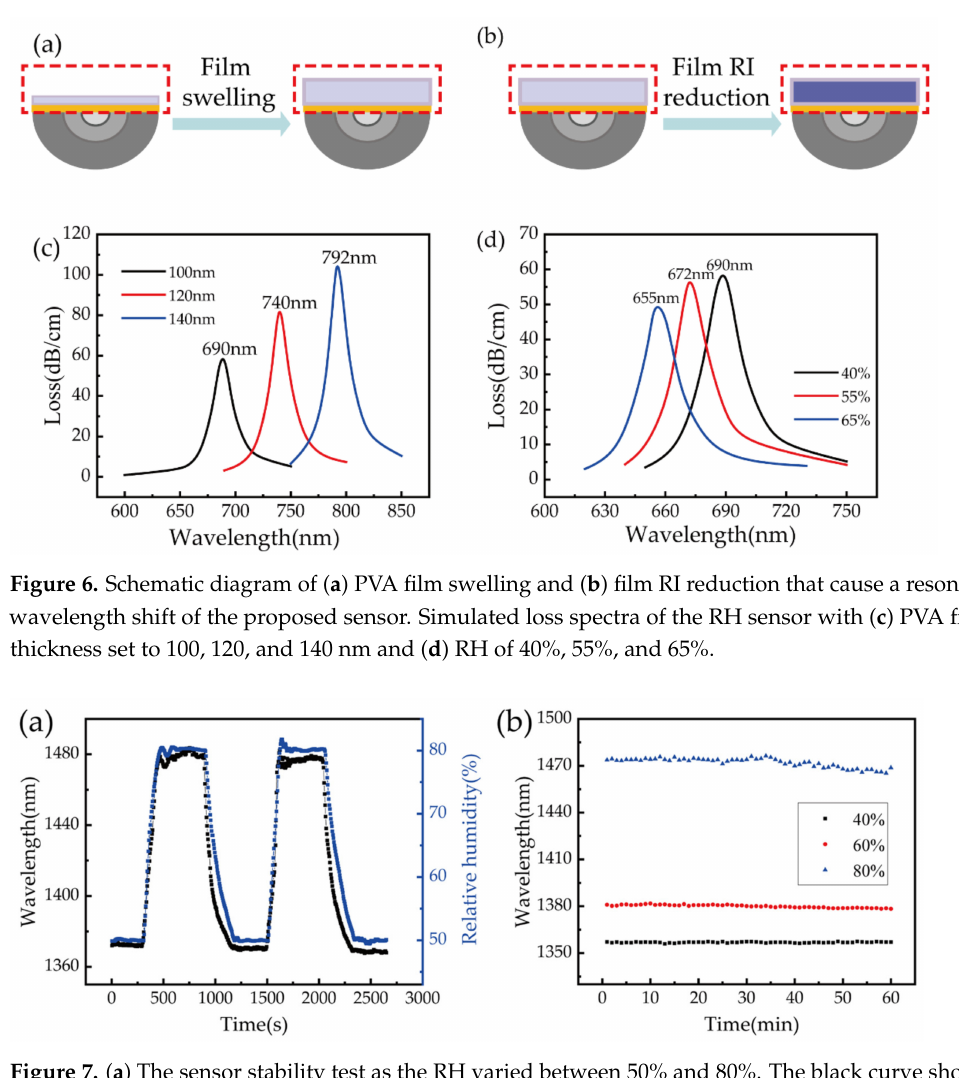
Figure 7. ( a ) The sensor stability test as the RH varied between 50% and 80%. The black curve shows the sensor response, and the blue curve shows data from the electric hygrometer. ( b ) Wavelength shifts in the resonance dip as the sensor was maintained at 40%, 60%, and 80%